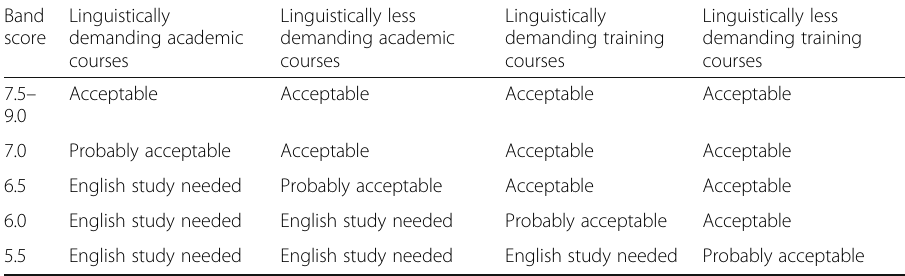
Table 1 Guidance on acceptability of IELTS test scores for academic and training courses Band Linguistically score demanding academic